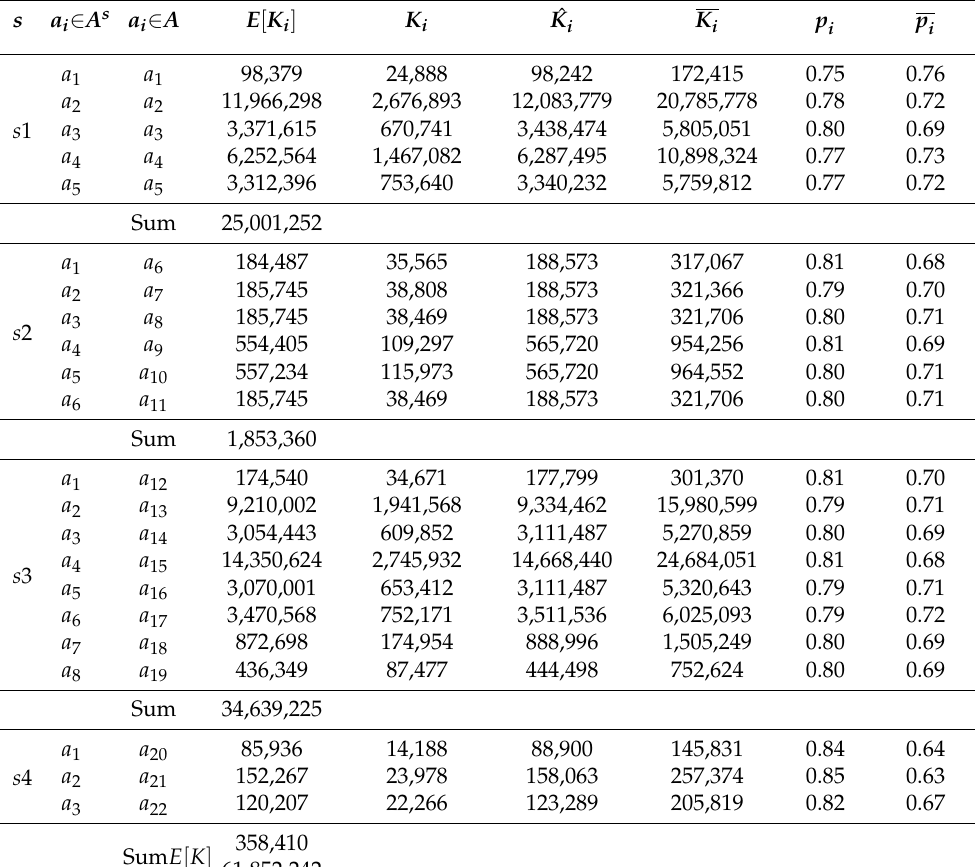
Table 3. Randomized data of costs.